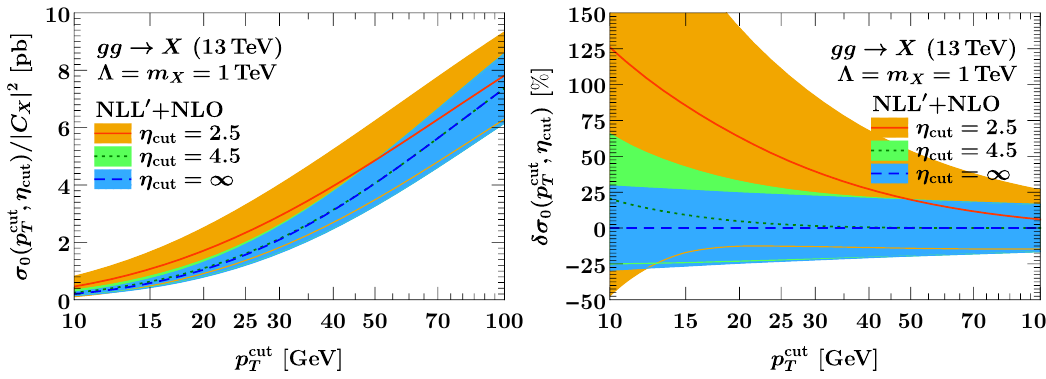
Figure 13 . 0-jet cross section (cid:27) 0 ( p cut values of (cid:17) cut . The bands indicate the total uncertainty (cid:1) (cid:22) 0 is shown on the left. On the right, the same results are shown as the percent di(cid:11)erence relative to the 0-jet cross section at (cid:17) cut =